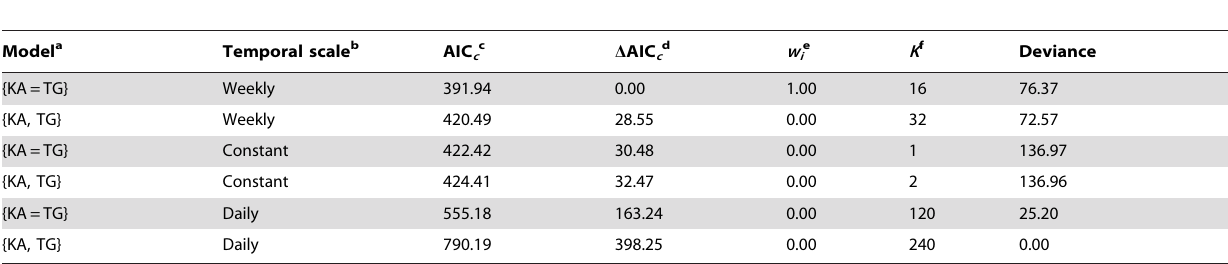
Table 9. Survival models using Program MARK for pronghorn from birth to 120 days using known-age newborn fawns and ages estimated from published neonatal-age models based on new-hoof growth, western South Dakota, USA,